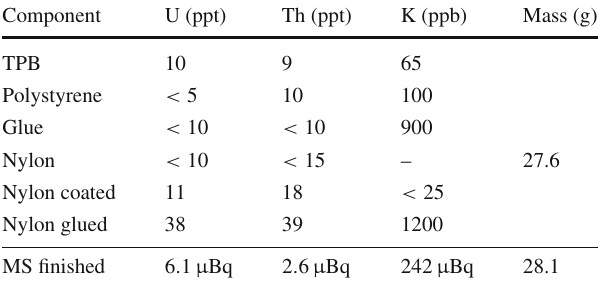
Table 5 Radioactive impurities of the components of one nylon mini- shroud (MS) from ICPMS measurements. Uncertainties are estimated to be about